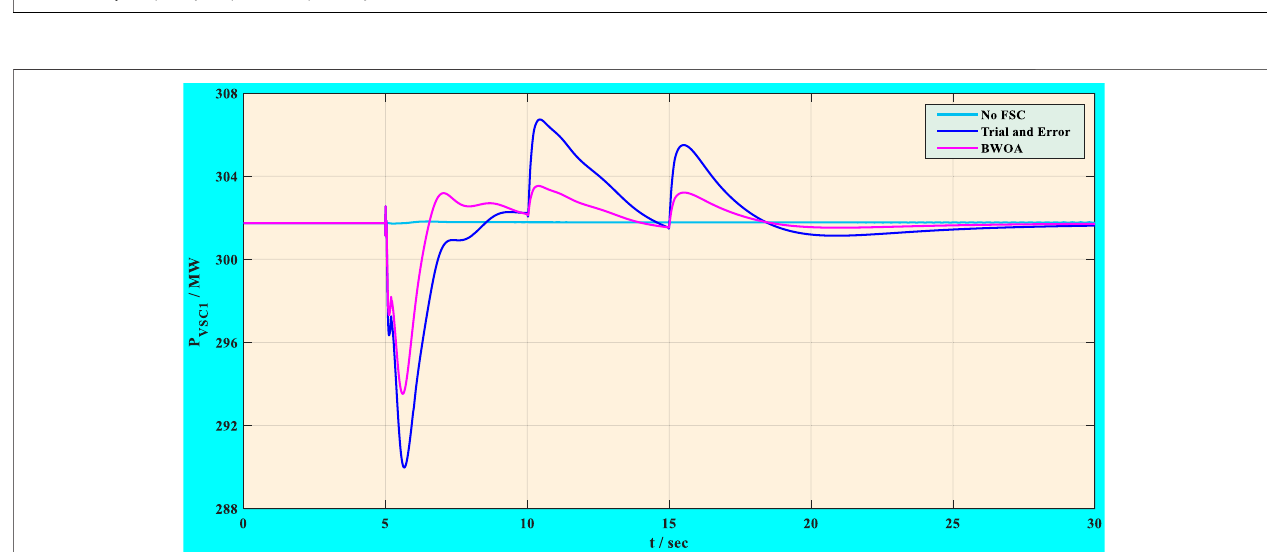
Frontiers in Energy Research |